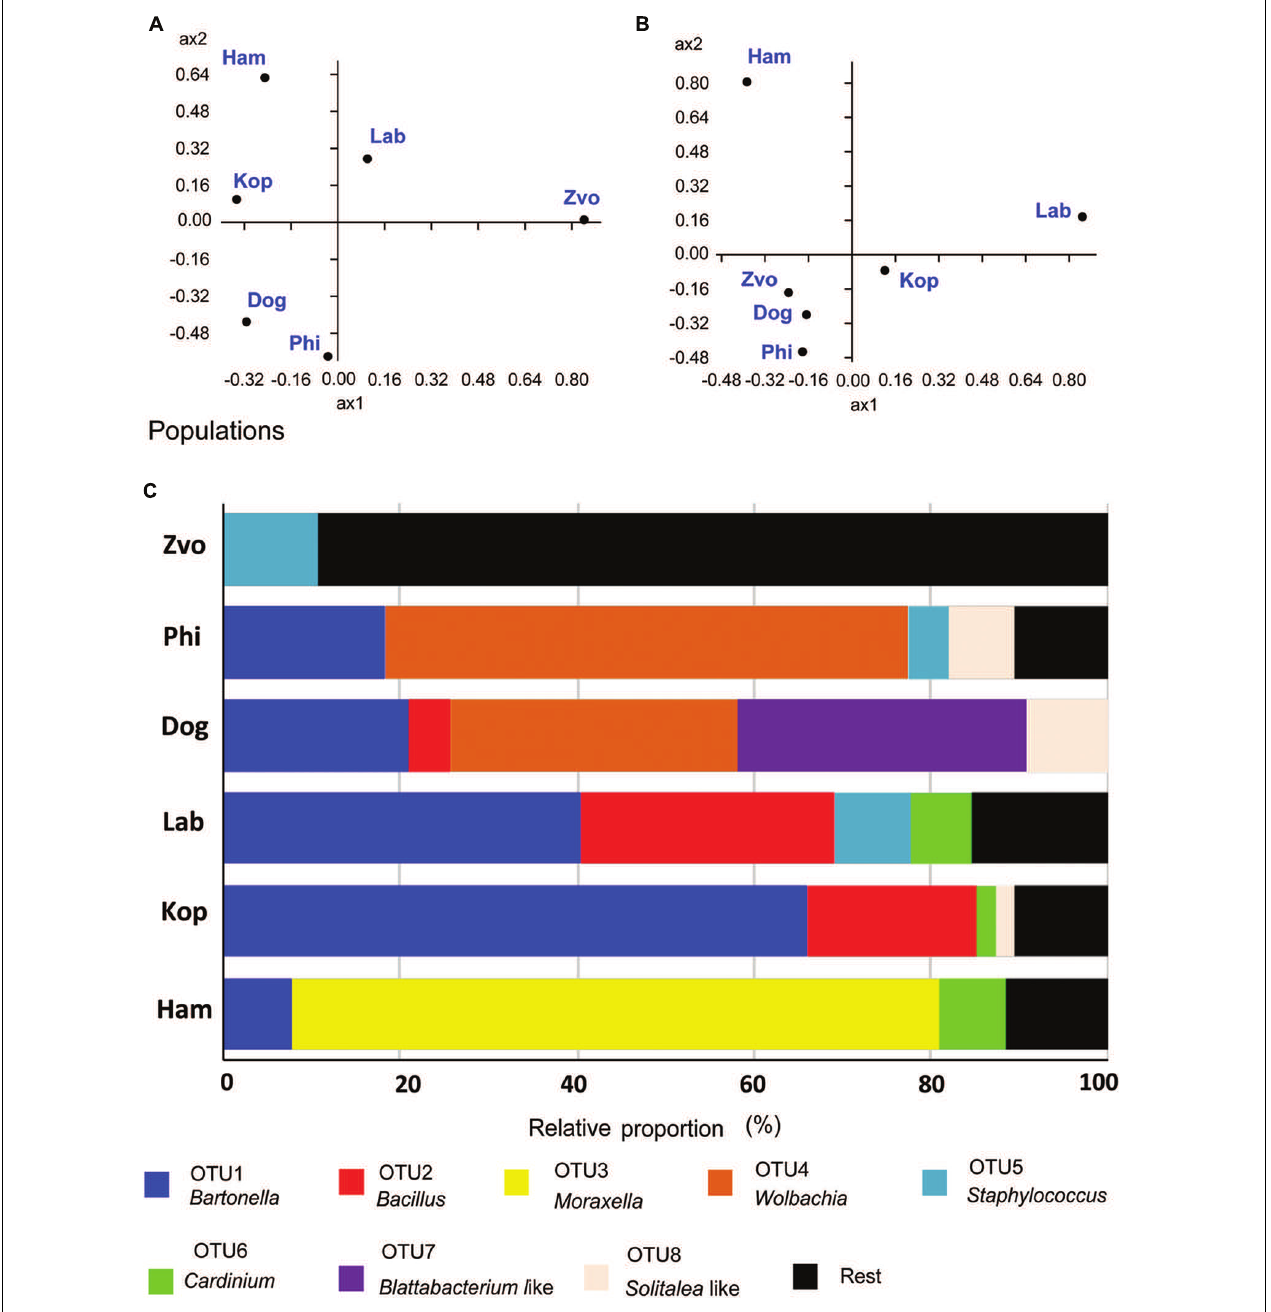
FIGURE 6 | Comparison of bacterial communities in T. putrescentiae populations based on Sanger sequencing of the 16S rRNA gene clones, the amplicons originated from eubacterial primers (F24/R1492): (A,B) principal coordinate analyses of bacterial communities in examined mite populations; (A) based on Euclidian distance; (B) based on Jacquard similarity index; (C) relative proportions of cloned bacterial sequences in our 16S rRNA library from different populations of T. putrescentiae . Abbreviations for the T. putrescentiae populations are listed in Table 1